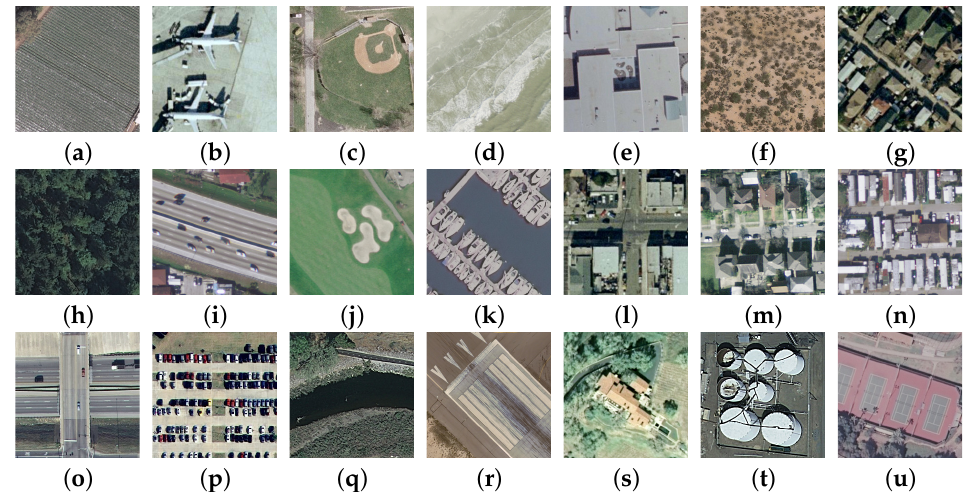
Figure 6. Example images in 21 categories in the UC Merced Land Use dataset. ( a – u ) Agricultural, airplane, baseballdiamond, beach, buildings, chaparral, denseresidential, forest, freeway, golfcourse, harbor, intersection, mediumresidential, mobilehomepark, overpass, parkinglot, river, runway, sparseresidential, storagetanks and tenniscourt, respectively.